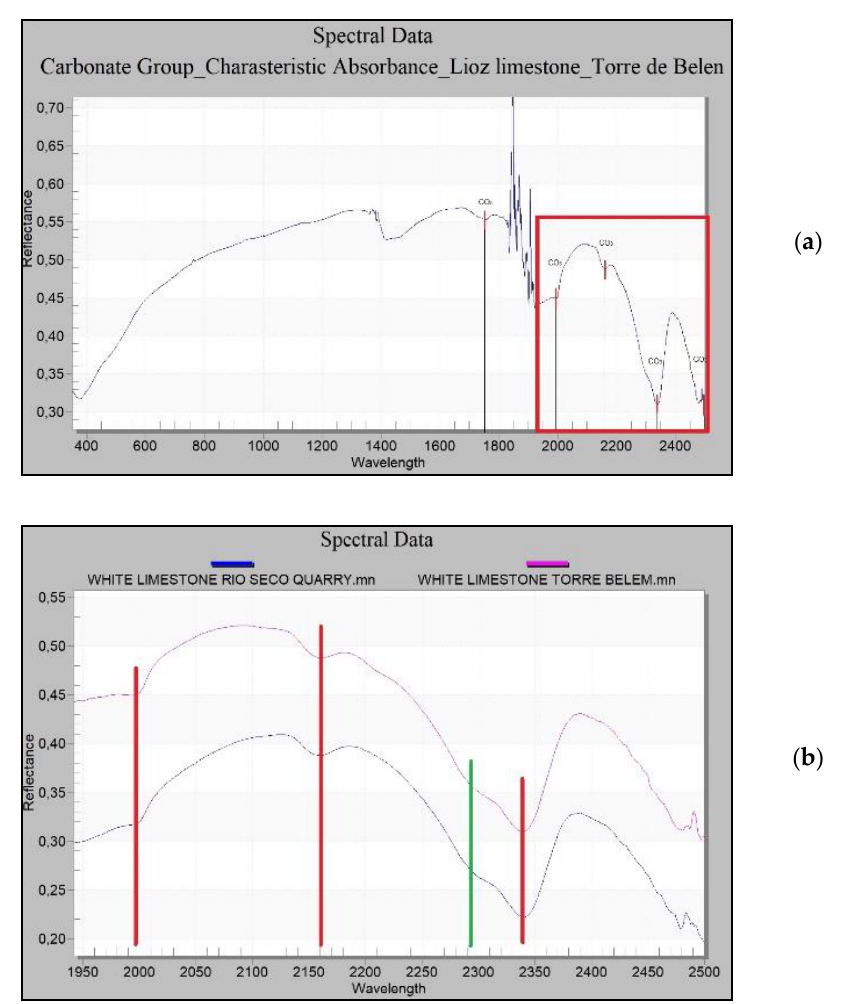
Figure 25. Comparison between the samples from the Tower of Belem and from the area of the white limestone in Rio Seco quarry. ( a ) Absorbance peaks of the carbonates group (CO 3 ) of the white limestone of the Tower of Belém; ( b ) Enlargement between wavelengths 1900 – 2500 nm for comparison. Common absorbance peaks (Red) and slope change (Green) for Tower of Belém and Rio Seco quarry signatures.